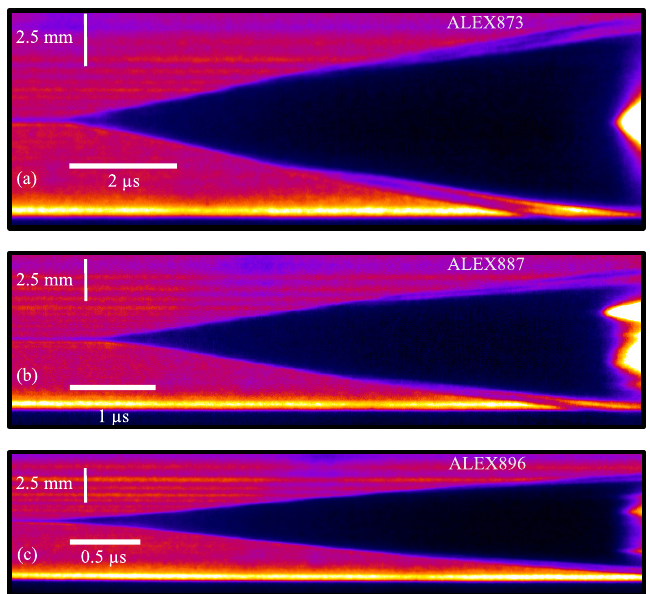
Figure 5. (Color online) typical iron streak images at ( a ) 10 kV, ( b ) 15 kV and ( c ) 20 kV of charging voltage in the capacitors bank. Notice the different scales.